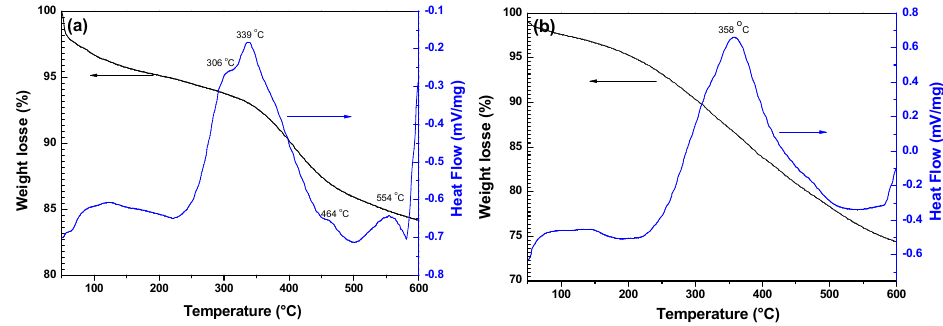
Figure 3. DSC-TGA profiles of ( a ) mSiO 2 @SPION and ( b ) Eu(TTA) 3 (P(Oct) 3 ) 3 @mSiO 2 @SPION.